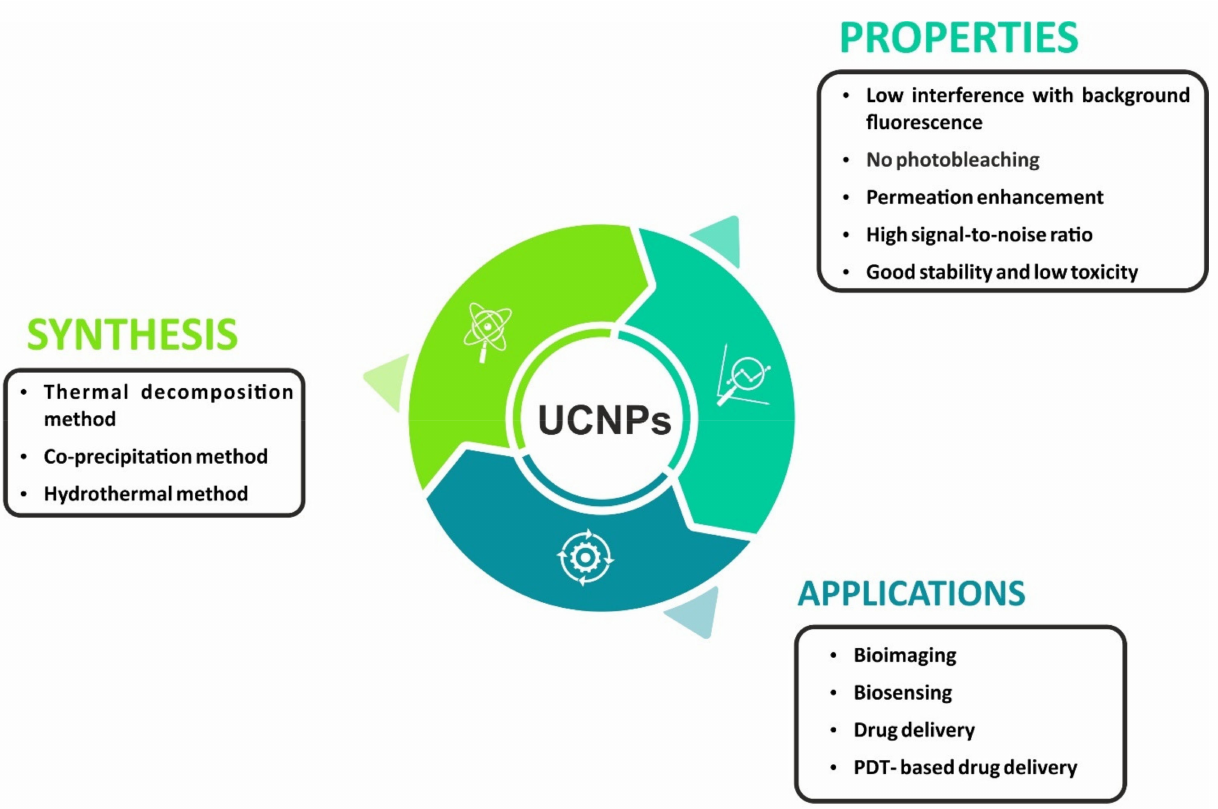
Figure 1. Synthesis, properties, and applications of